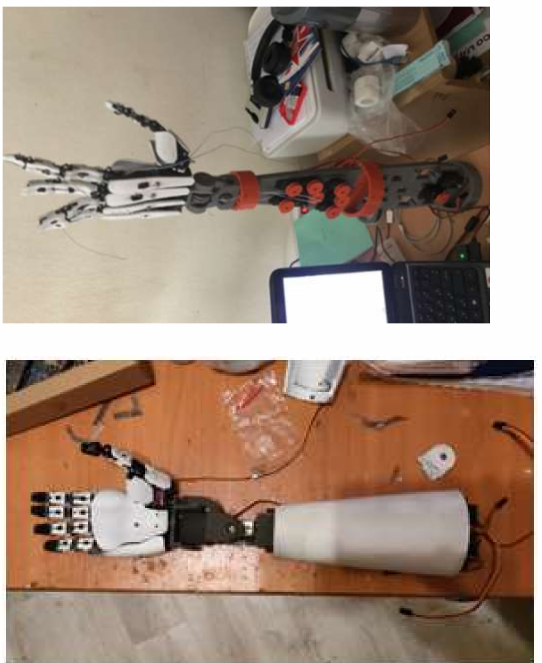
Figure 5. Engineered construction of an anthropomorphic robotic